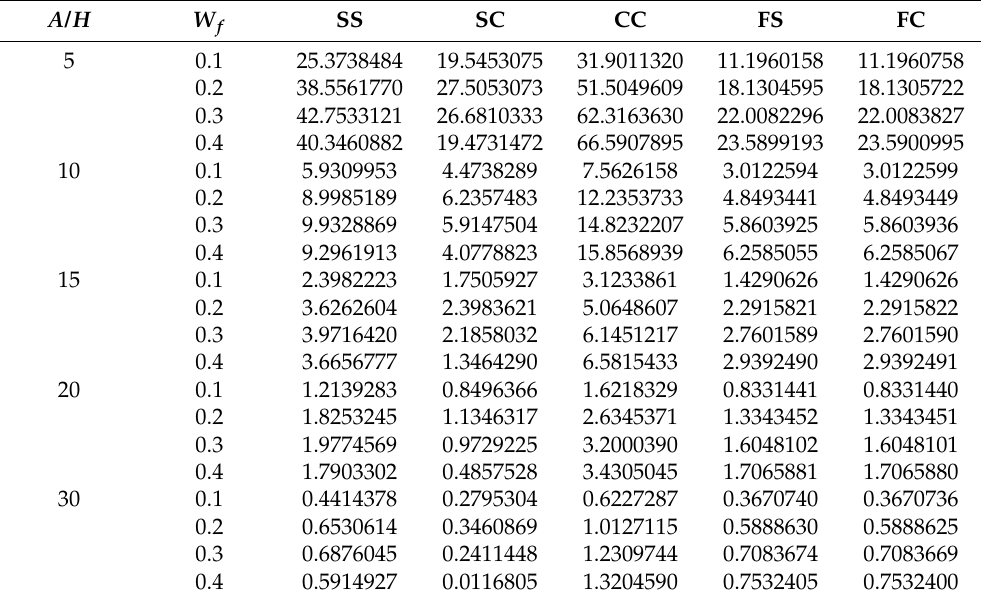
Table 7. Dimensionless in-plane shear stress σ ∗ of FG porous nanocomposite piezoelectric square 12 plates under various boundary conditions and for different values of side-to-thickness ratio A / H and GPLs weight fraction W f ( x 3 / H =